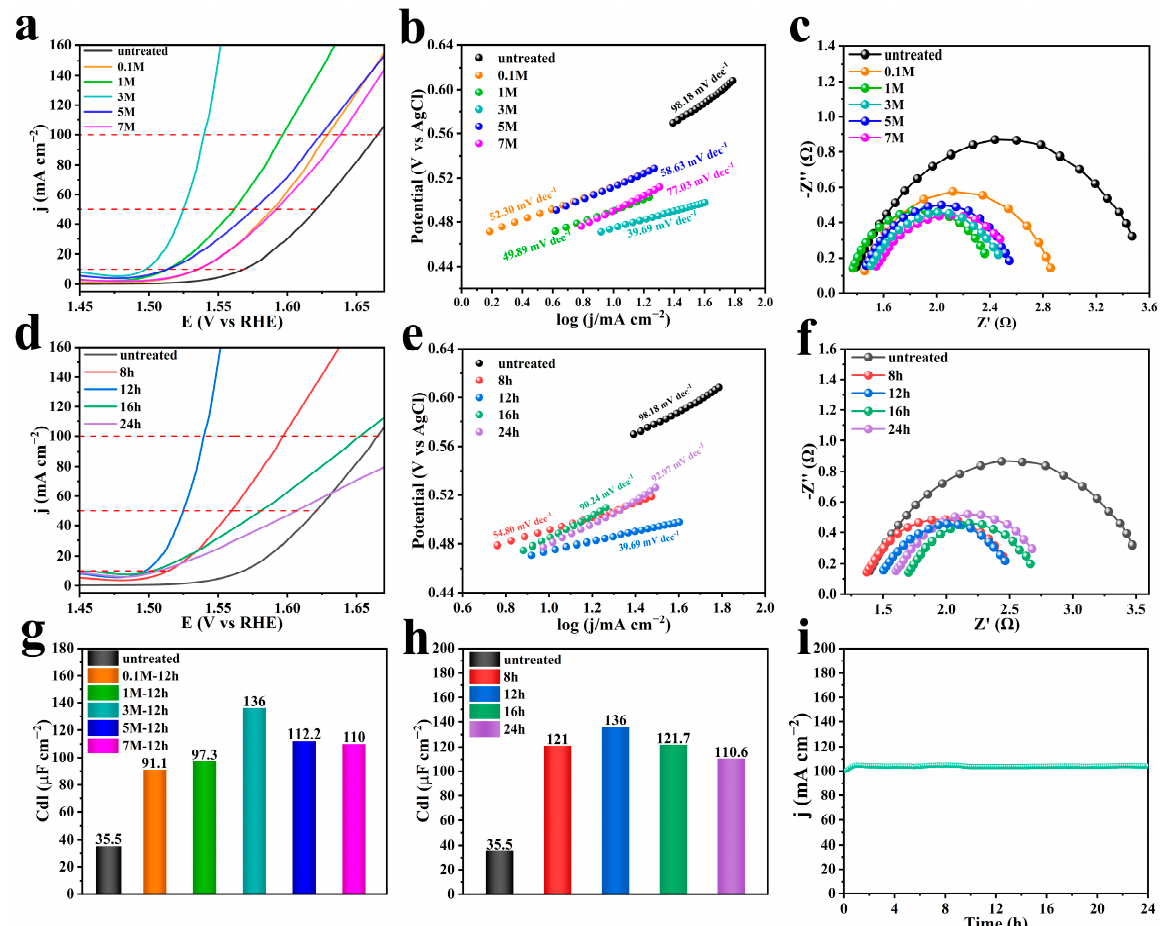
Figure 2. Electrocatalytic performance of as ‐ prepared samples in 0.5 M NaCl + 1 M KOH solution. ( a , d ) OER polarization curves. ( b , e ) corresponding Tafel slope. ( c , f ) Nyquist plots. ( g , h ) C dl values. ( i ) current density ‐ time curve.